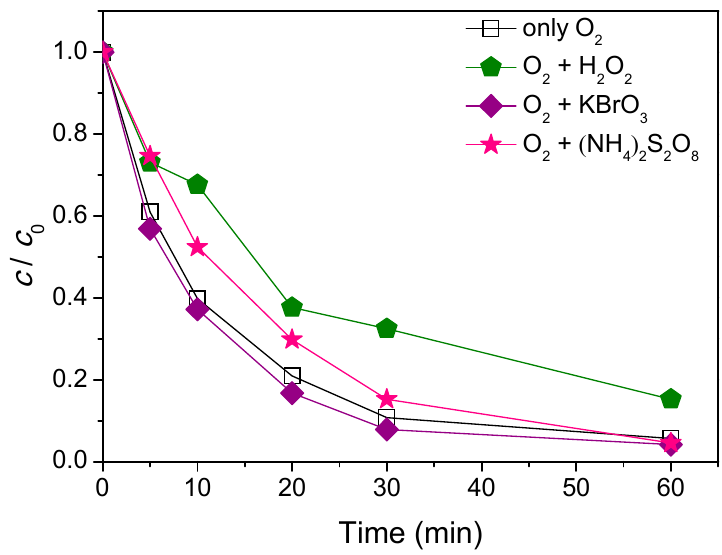
Figure 6. The effect of addition of various electron acceptors (3.0 mmol/L) on the kinetics of AMI (0.0300 mmol/L) photocatalytic degradation using ZnO (1.0 mg/mL) and solar